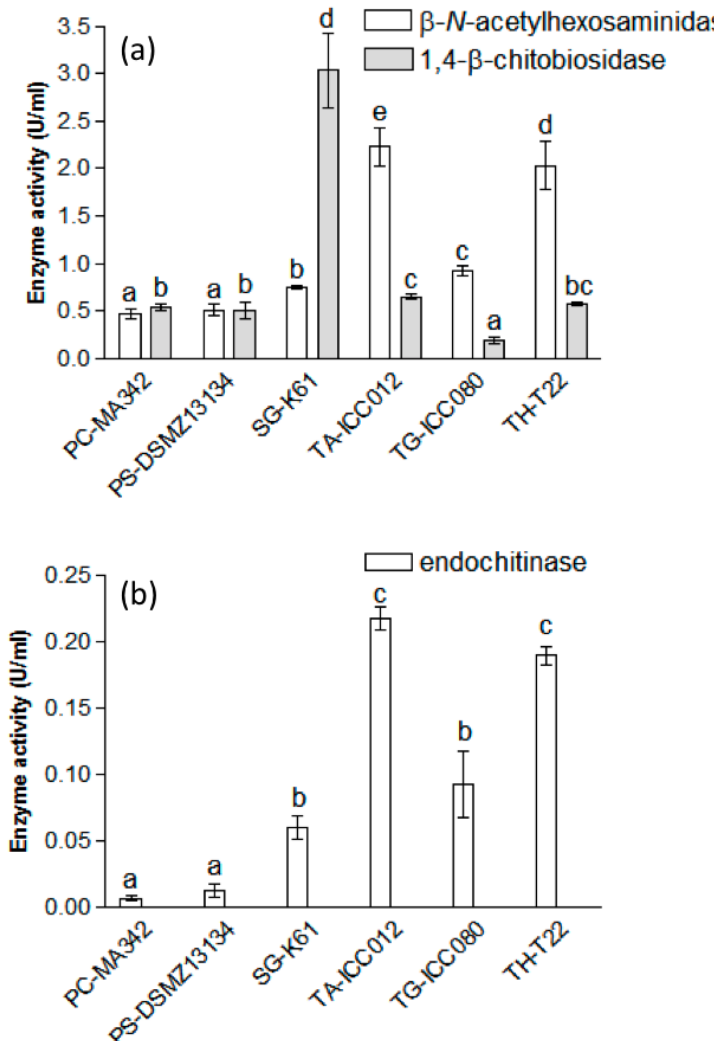
Figure 1. β -N-acetylhexosaminidase and chi- tin 1,4- β -chitobiosidase activities (a) and en- dochitinase activity (b), determined in culture filtrates of each antagonist, PC-MA342, PS- DSMZ13134, SG-K61, TH-T22, TA-ICC012 and TG-ICC080, grown for 7 d in synthetic medium containing cell wall of FSC as carbon source. One unit (U) of enzyme activity was defined as the amount of enzyme which releases 1 ηmol of p -nitrophenol per minute. Data are averages ± 1SD. Columns with different letters within each enzymatic activity are significantly different by Duncan’s Multiple Range Test